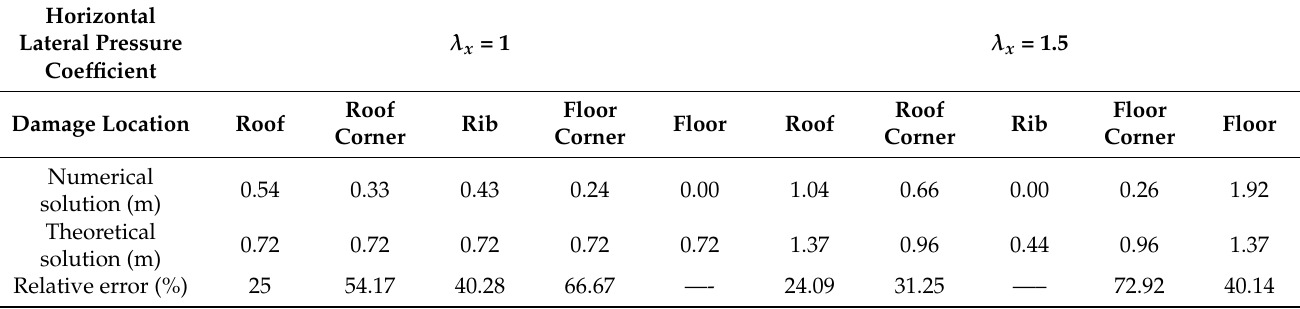
Table 3. Theoretical and numerical solutions of plastic zone range in the three-dimensional roadway.